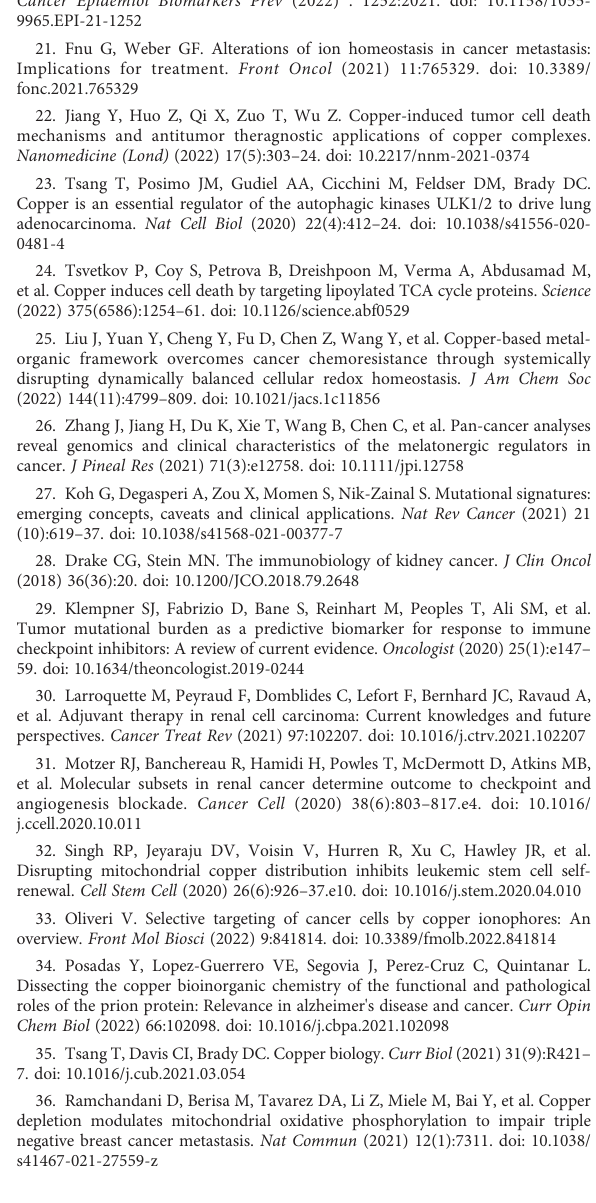
SUPPLEMENTARY FIGURE 4 Immunohistochemical detection of FDX1 in tumors of different grades in Taizhou